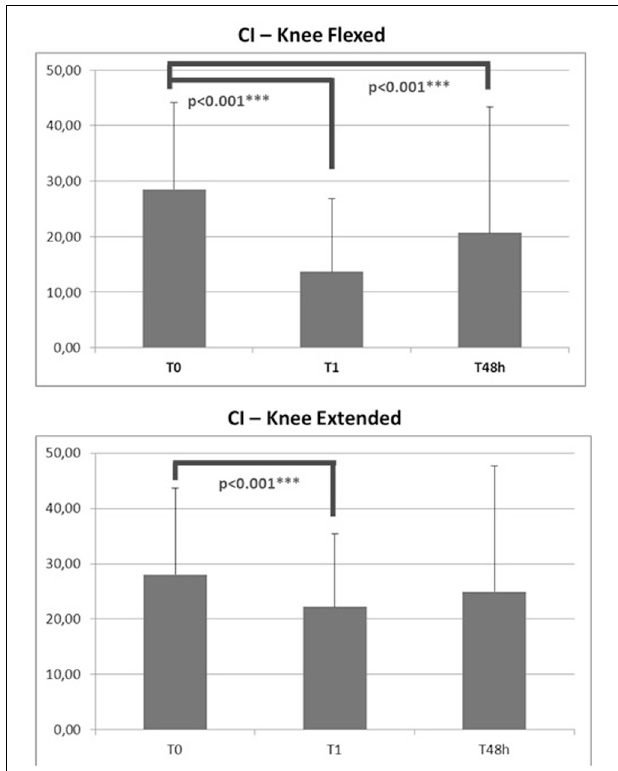
FIGURE 3 | CI index at T 0 , T 1 , and T 48h for EXP group. ∗∗∗ p < 0 . 001.